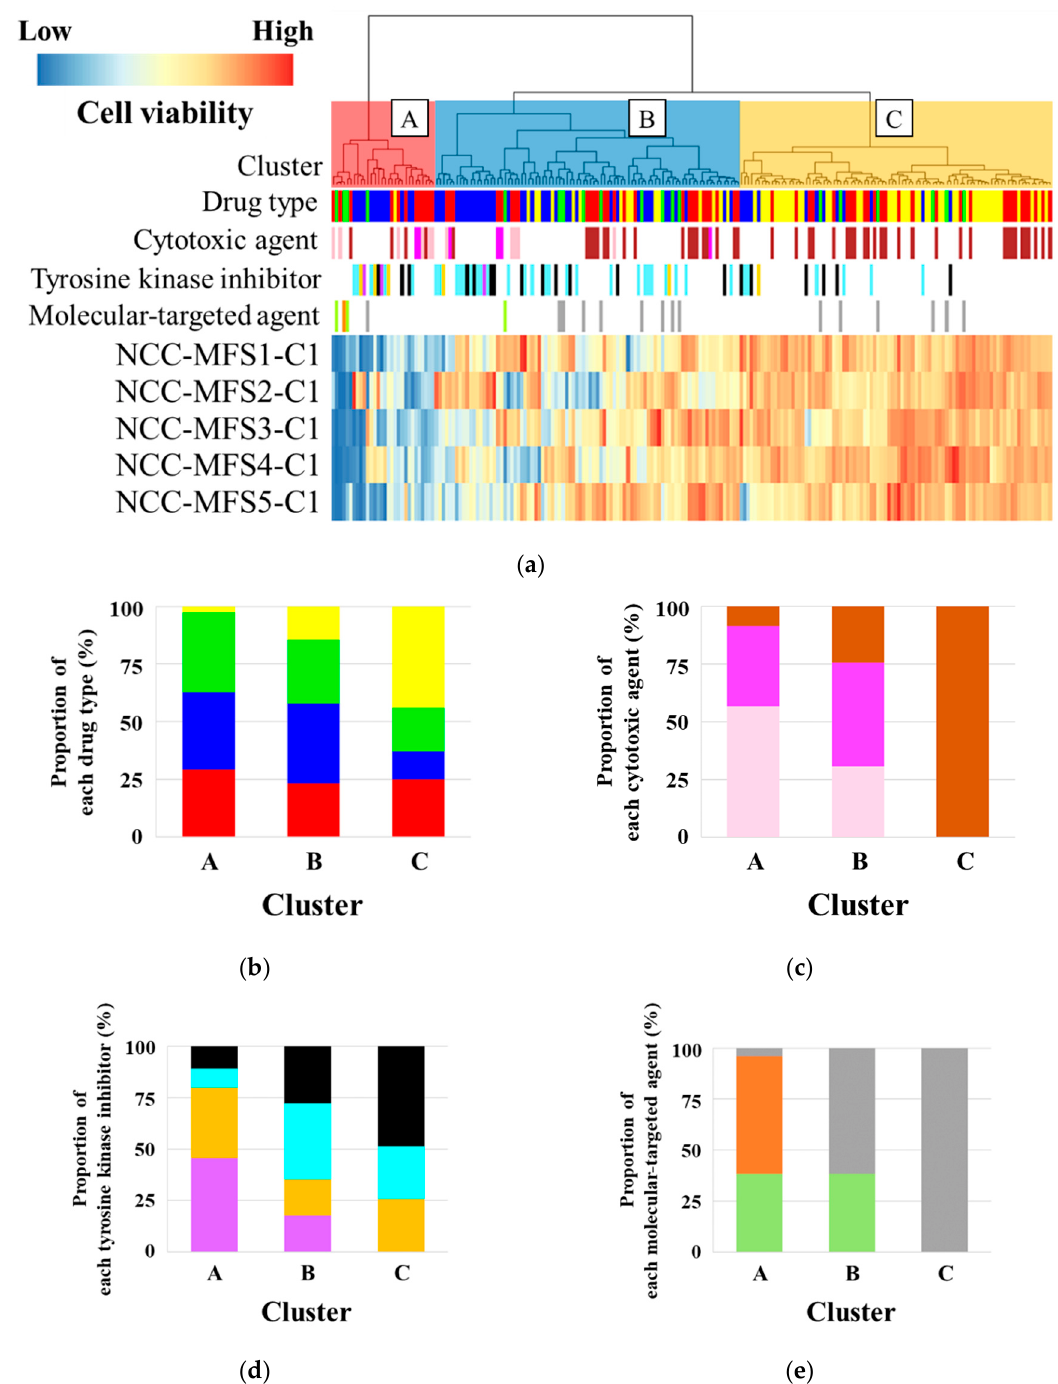
Figure 4. Drug screening tests on MFS cell lines. ( a ) The drugs were categorized into three groups according to their antitumor effect: cluster A, effective group; cluster B, intermediate effect group; cluster C, poor effect group. ( b – e ) The proportion of each drug type belonging to each cluster. The graphs are depicted after the normalization of the number of drugs. Data concerning NCC-MFS1-C1, NCC-MFS2-C1, NCC-MFS3-C1, and NCC-MFS4-C1 were previously reported [28–31].